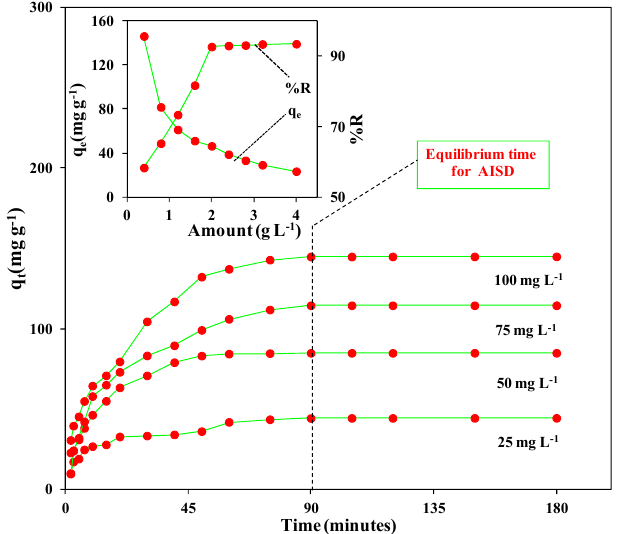
Figure 6. Effect of CV/AISD contact time on adsorption capacity for different initial dye concentra- tions at 303 K (inset − effect of adsorbent dose on adsorption capacity and percentage removal).